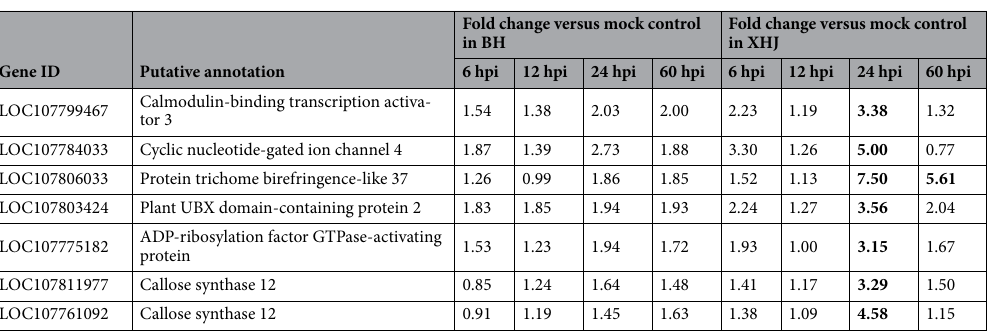
Table 4. Analysis of candidate susceptible genes significantly induced in XHJ. The gene expression data at 6, 12, 24 and 60 hpi were compared to data in mock-infected control and the fold change is demonstrated.